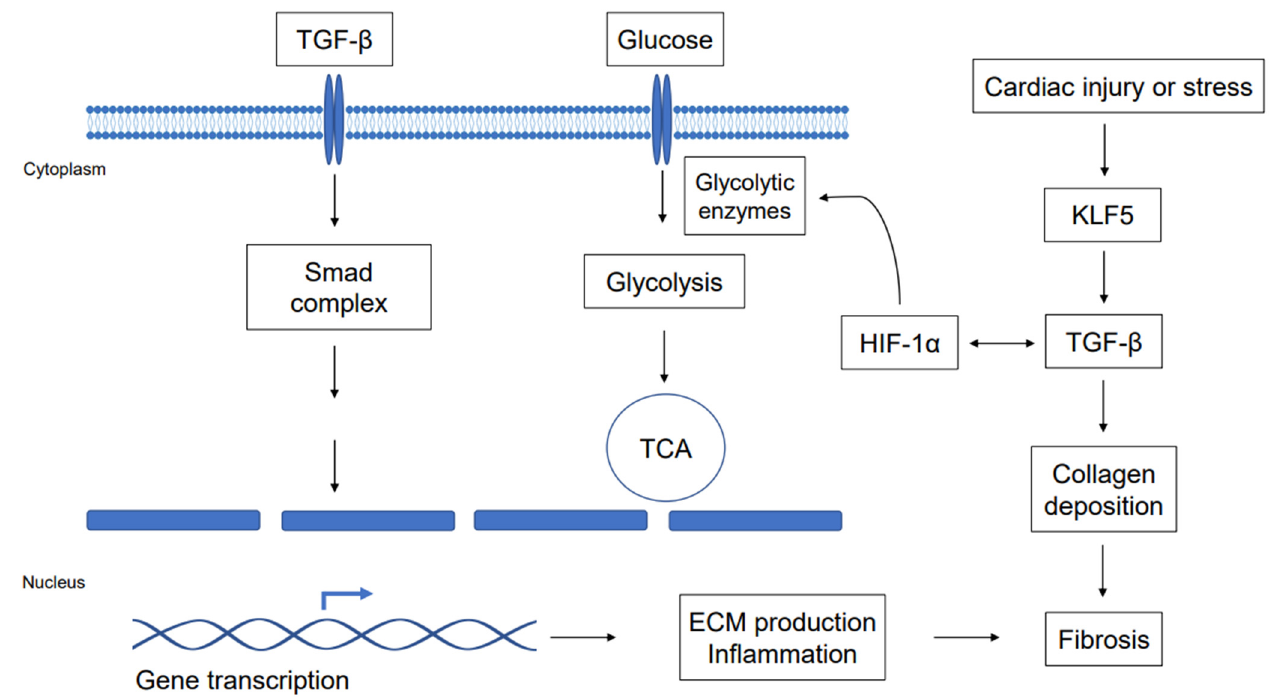
Figure 1. Cooperation of TGF- β -Smad signaling fibrosis, the glycolysis pathway, and KLF5 as regulators of fibrosis. The stress or injury in the heart upregulates KLF5 and subsequently induces TGF- β . In TGF- β -Smad signaling, TGF- β activates the Smad complex, resulting in an increase in the production of ECM and causing fibrosis. Moreover, HIF-1 α may regulate TGF- β in fibrosis development and control the glycolytic enzymes in the glycolysis pathway.